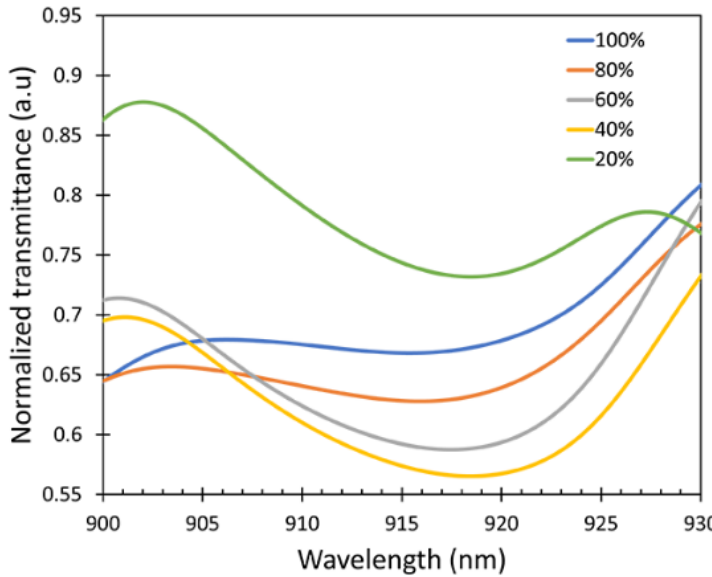
Figure 9. Transmittance spectra peak shifts of the fiber sensor.